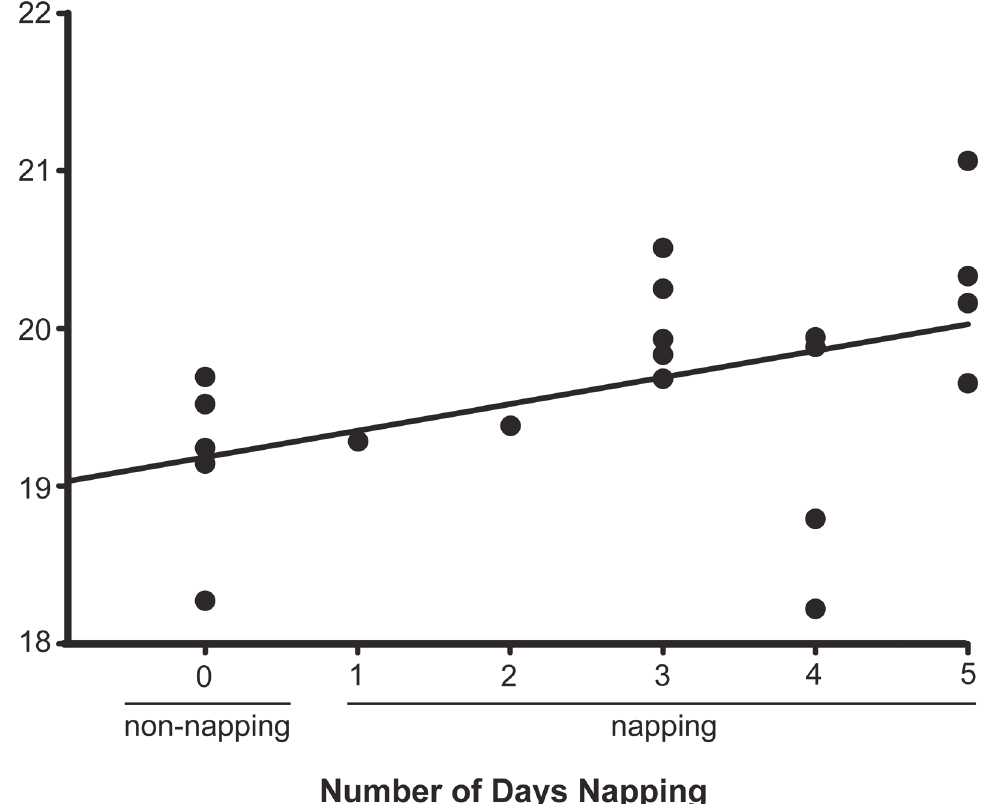
Fig 1. Scatterplot showing the association between napping and circadian phase in toddlers (n = 20). Number of days that toddlers napped during the 5-days preceding the dim light melatonin onset (DLMO) assessment was estimated with actigraphy ( r = 0.49, p =